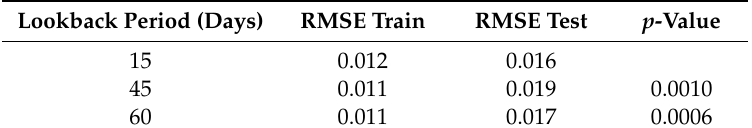
Figure 7. Above shows the change in portfolio value over time when the strategies long-short ( Left ) and buy-sell ( Right ) are implemented on the test data. Due to short selling, daily settlement the long- short portfolio incurs transaction fees which reduces growth and increases volatility in the portfolio. 6. Conclusions There have been a considerable number of studies on Bitcoin price prediction using machine learning and time-series analysis (Wang et al. 2015; Guo et al. 2018; Karakoyun and C ̧ ibikdiken 2018; Jang and Lee 2017; McNally et al. 2018). However, most of these studies have been mostly based on